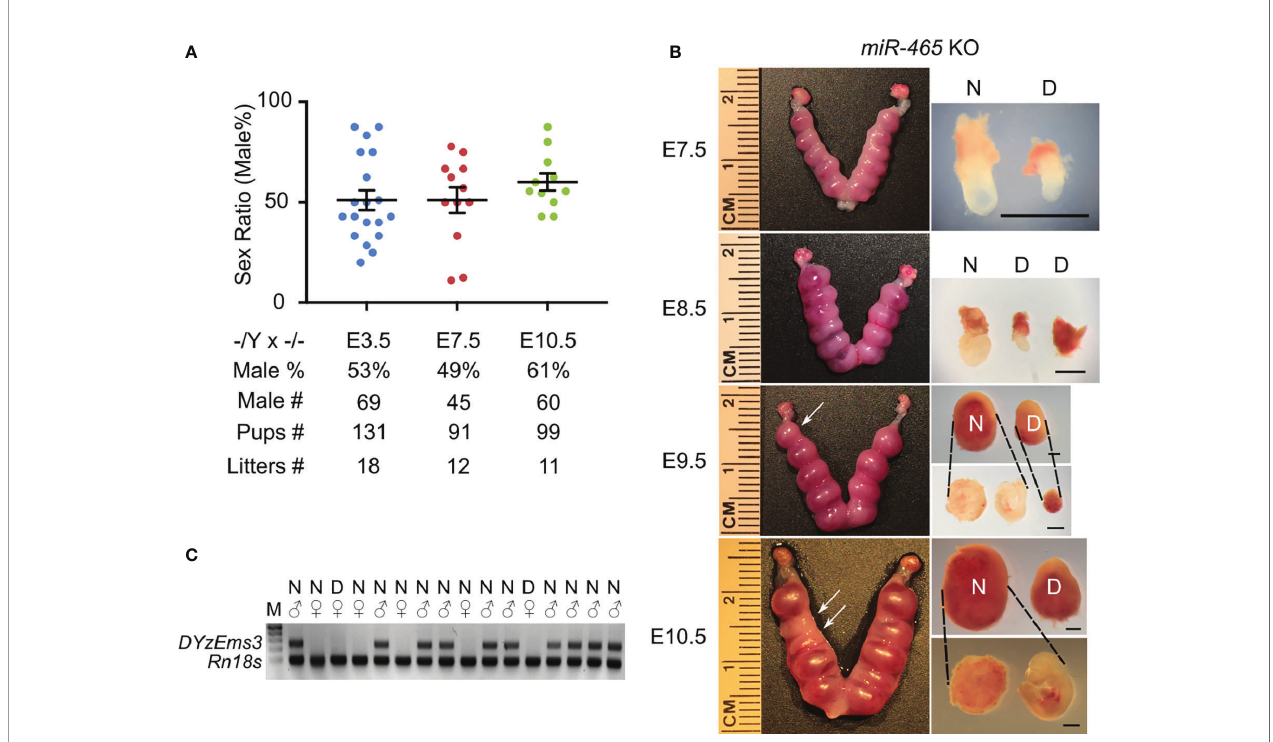
FIGURE 2 | The phenotype of miR-465 KO mice. (A) The sex ratios of pups from homozygous inbreeding (-/Y × -/-) at E3.5, E7.5, and E10.5. (B) Representative images of the KO uteri and conceptuses collected between E7.5 and E10.5. Arrows point to the degenerating/degenerated conceptuses (D) among the normal- looking (N) ones. Scale bars = 1mm. (C) A representative gel image of genotyping results. DYzEms3 , a Y-linked genomic fragment, was ampli fi ed to identify male conceptuses, and Rn18s , which encodes 18s ribosomal RNA, was used as a loading control in the PCR-based genotyping